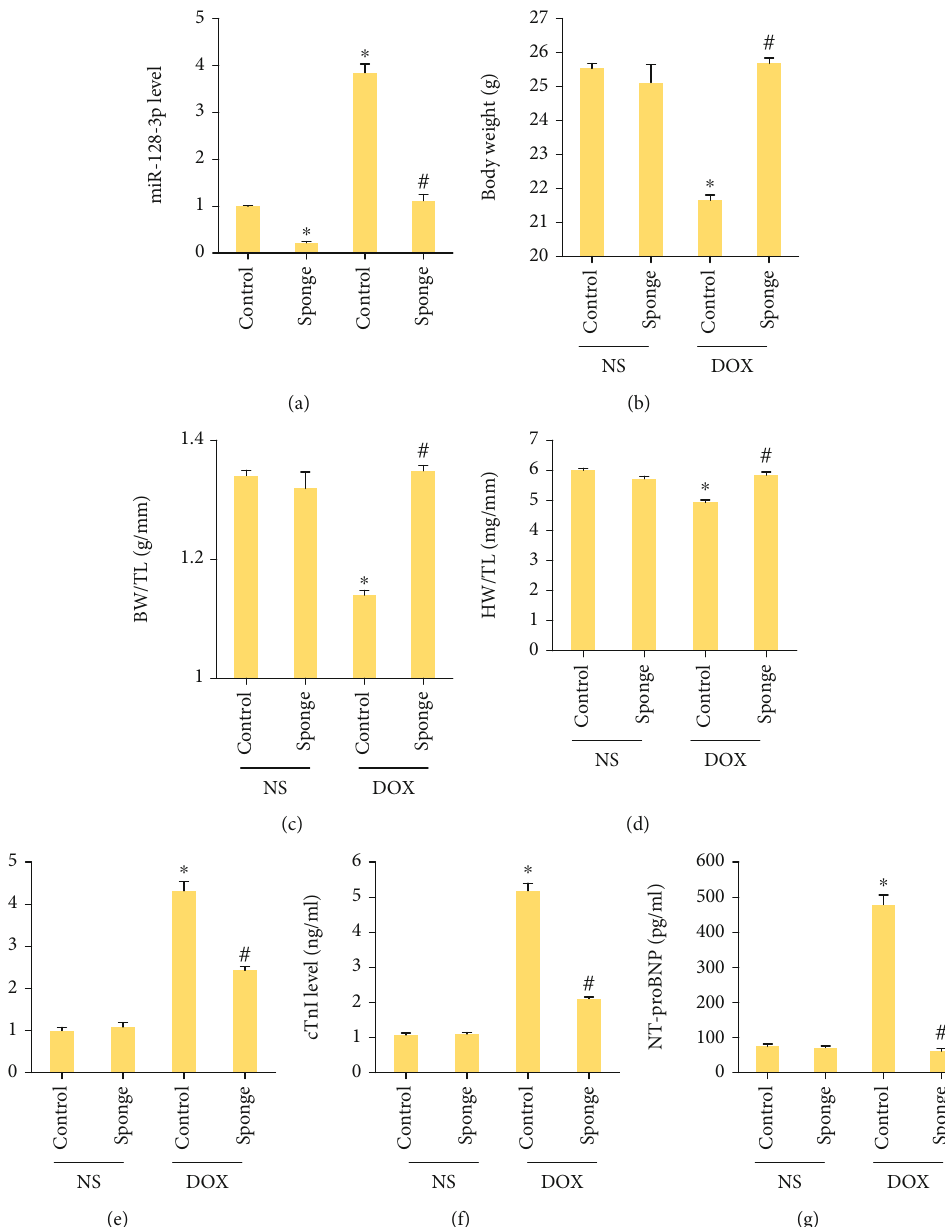
Figure 2: miR-128-3p inhibition attenuated cardiac injury in DOX-treated mice. (a) The level of miR-128-3p expression in the hearts ( n = 6 ). (b) Body weight ( n = 12 ). (c) The ratio of body weight to tibial length ( n = 12 ). (d) The ratio of heart weight to tibial length ( n = 12 ). (e) The mRNA level of BNP in the hearts ( n = 6 ). (f, g) The plasma levels of cTnI and NT-proBNP ( n = 6 ). Data are expressed as mean ± SEM . ∗ P < 0 : 05 vs. NS/control group; # P < 0 : 05 vs. DOX/control